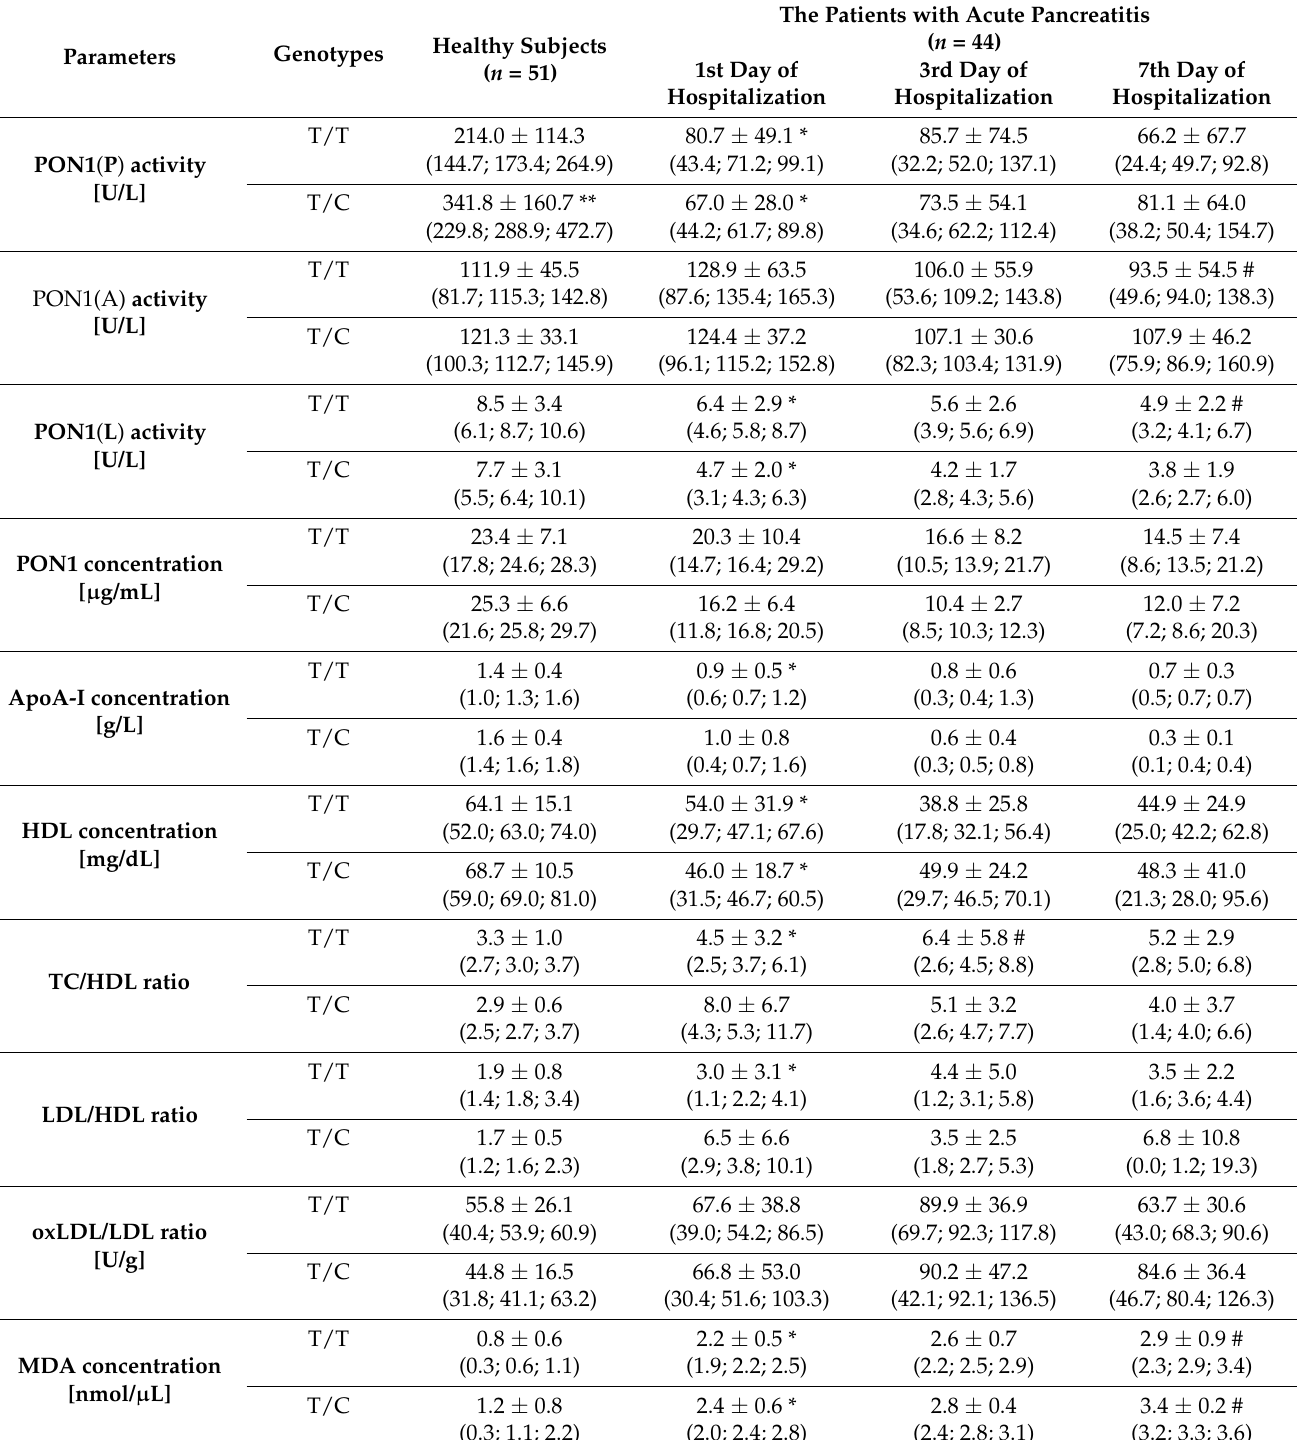
Table 4. The activities of PON1, its concentration, the concentration of apoA-I, lipid profile parameters, and selected markers of pro/antioxidative balance in the context of genotypic variability of rs662 in the PON1 gene in the group of healthy subjects and AP